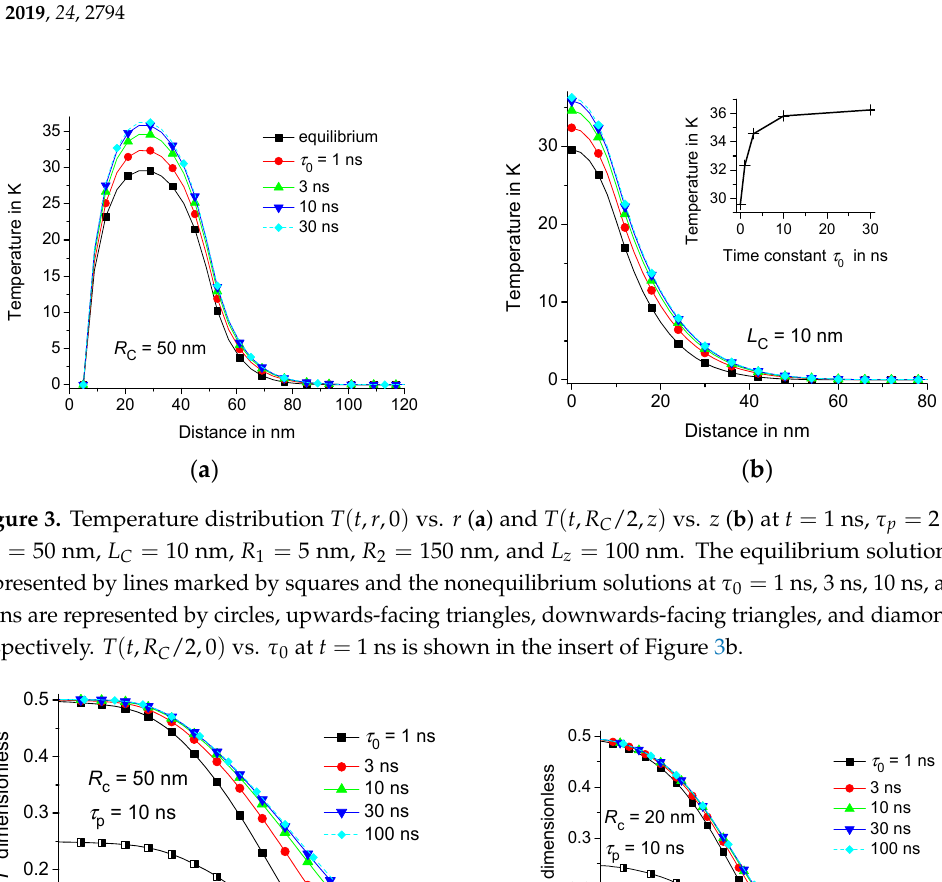
( b ) Figure 2. Time dependence of equilibrium solution 𝑇(cid:3560)(𝑡, 𝑅 (cid:3004) /2,0) is represented by the lines marked by squares and those at nonequilibrium 𝑇(𝑡, 𝑅 (cid:3004) /2,0) at 𝜏 (cid:2868) = 1 ns, 3 ns, 10 ns, and 30 ns are respectively represented by circles, upwards-facing triangles, downwards-facing triangles, and diamonds for 𝑅 (cid:3004) = 50 nm ( a ) and 20 nm ( b ); 𝑅 (cid:2869) = 5 nm, 𝑅 (cid:2870) = 150 nm, and 𝐿 (cid:3053) = 100 nm are represented by the filled symbols, as well as 𝑅 (cid:2870) = 300 nm and 𝐿 (cid:3053) = 200 nm are represented by the open symbols. Note that the temperature is counted from 𝑇 (cid:3047) . The thermal response of the polymer matrix with delayed dynamic heat capacity is larger than